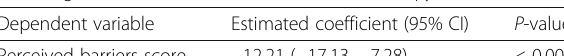
Table 8 Construct Validity* Association between Perceived barriers score, and screening or not screening with the “ home ” test (FOBT) or